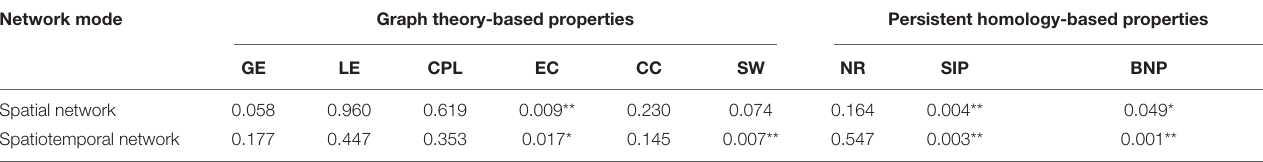
TABLE 3 | Statistical p -values of different network properties between AD and NC groups in a default mode network (DMN). Network mode